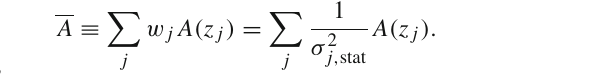
Fig. 8 Experimental points (cid:2) p ered experiments: EG1b [4] (lighter) and EG1-DVCS [5] (darker). The smaller uncertainties are statistical, δ(cid:2) p larger are systematic, δ(cid:2) p EG1-DVCS points have very small statistical uncertainties σ j , stat (the resolution of the figure is too small to see